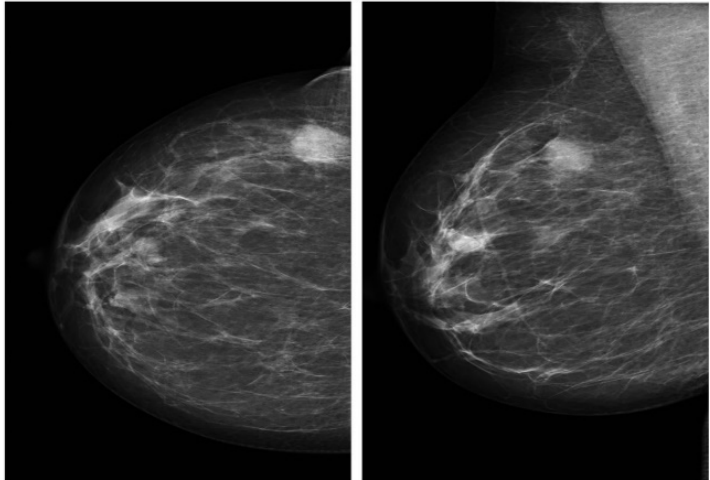
Figure 2. Mammography in CC and MLO views, respectively. Table 2. Mammography datasets for breast cancer